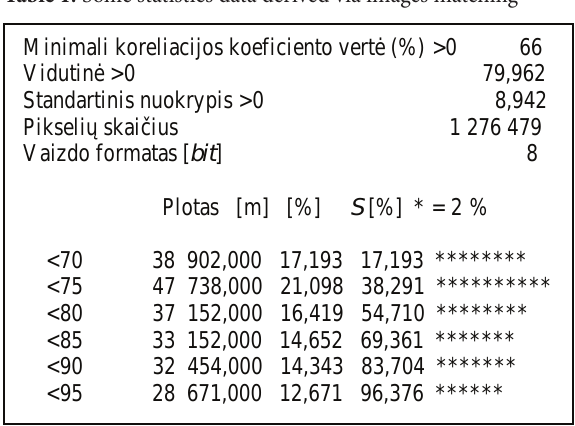
Table 1. Some statistics data derived via images matching